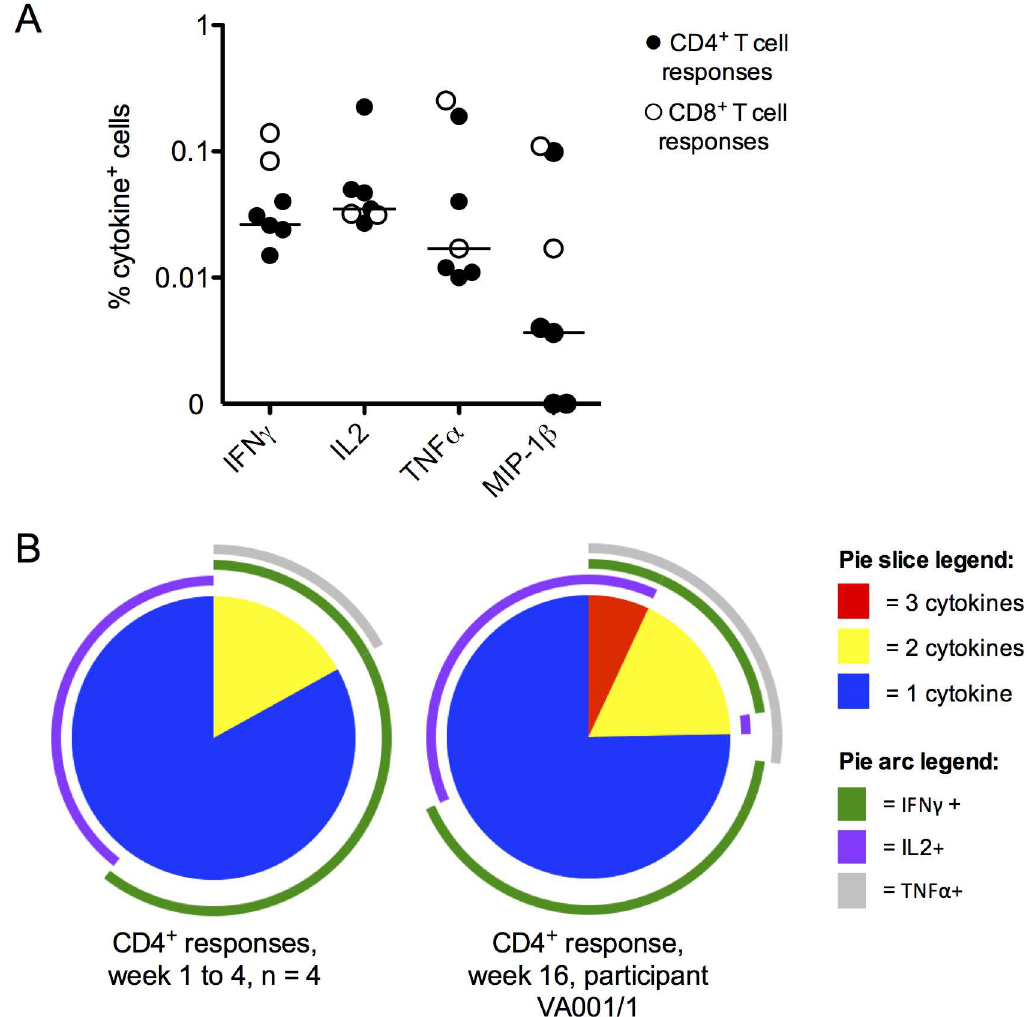
Fig 3. Cytokine production by JE vaccine specific T cells by intracellular cytokine staining (ICS). (A) Magnitude of T cell cytokine responses to JEV SA14-14-2 detected by flow cytometry/ICS in five participantsshowingpositive responses. Data are the percentage of cells in the parent (CD4 + /CD8 + ) gate stainingfor the indicatedcytokine, above unstimulated values. Filled circles = CD4 + responses, open circles = CD8 + responses. Bars = medianvalue of CD4 + responses only. (B) SPICE analysisof CD4 + T cell responsesdetected by flow cytometry. Data are the proportionof the responsecomprisedof IFN γ + /IL2 + /TNF α + triple positive cells (red pie slices), doublepositive cells (yellowslices) and single positive cells (blue slices). Arcs indicatethe proportionof the responseproducingindividual cytokines: IFN γ (purplearcs), IL2 (green arcs) and TNF α (light grey arcs). Left pie chart: CD4 + responsesat weeks 1–4 (n = 4), right pie chart: participantVA001/1 at week 16. ParticipantVA001/1 made a triple positive responseat week 16 after vaccination,hencethis participant is presented separately.